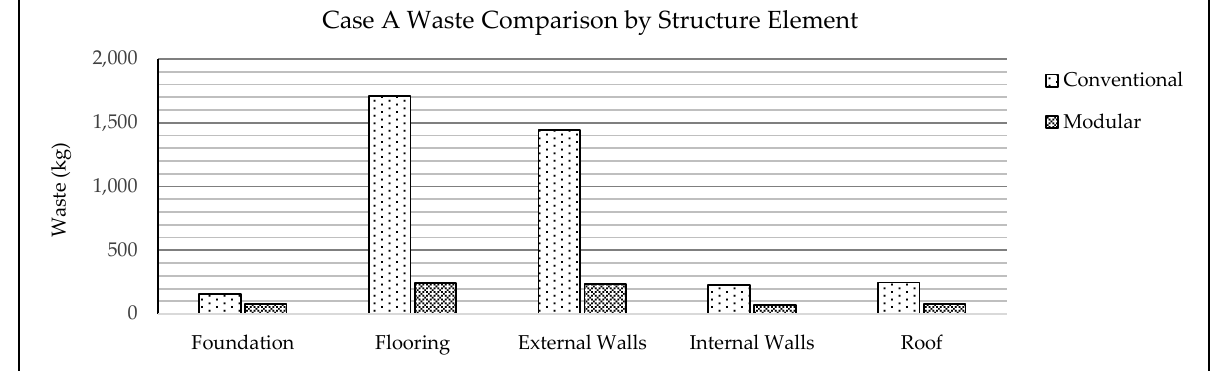
Figure 3. Case A waste comparison by structure element.